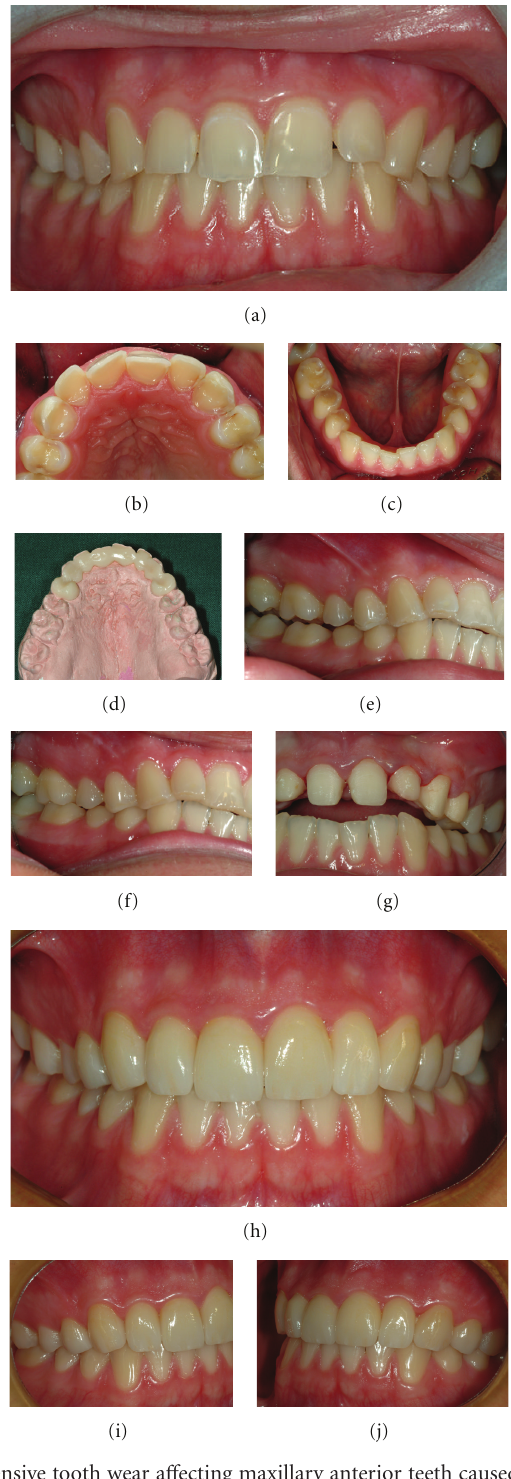
Figure 12: A 19-year-old man with extensive tooth wear a ff ecting maxillary anterior teeth caused by excessive soft drink intake, drunk by the “retaining” drinking technique (a–c). Note the pronounced wear on palatal and buccal surfaces with shoulder formations (b). Patient is provided with palatal acrylic onlays ad modum Dahl (cemented with resin cement) producing posterior disclusion (d, e). After 4 months the posterior occlusal relationship has normalized (f) and after preparation there is enough space for the restorations (g). Full ceramic Empress crowns cemented on teeth nos. 14–24 (h–j) [13,